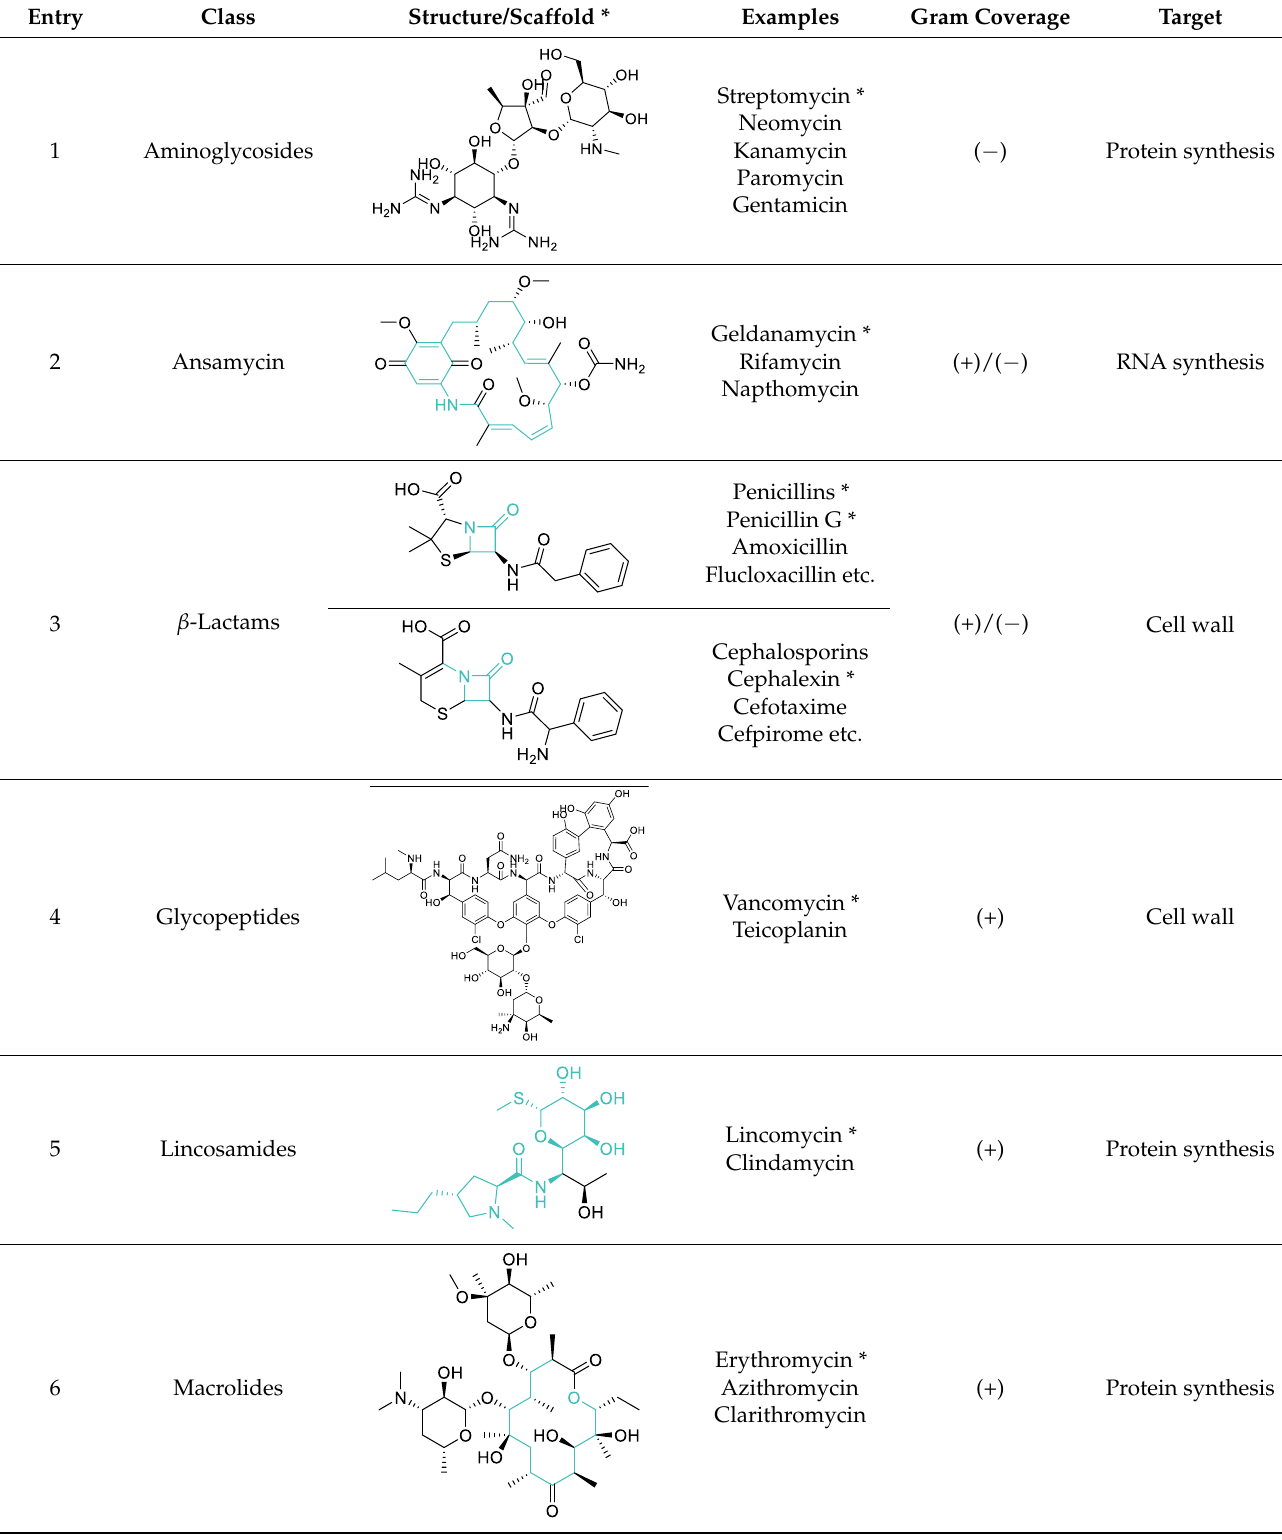
Table 1. Classes of antibiotics with their mode of action.